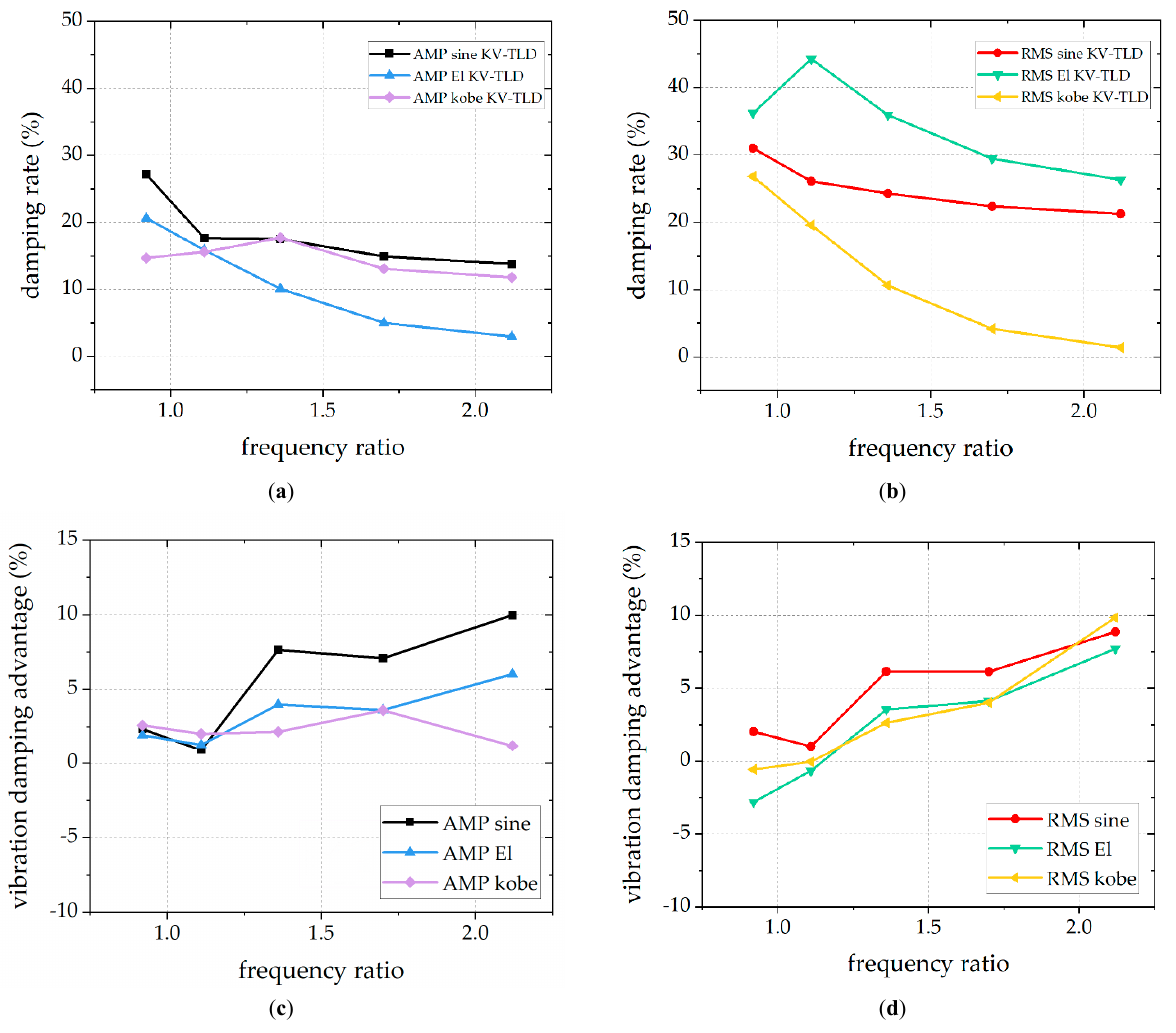
Figure 7. Frequency ratio analysis: mass ratio (3%): ( a ) damping rate (AMP); ( b ) damping rate (RMS); ( c ) vibration damping advantage (AMP); ( d ) vibration damping advantage (RMS).